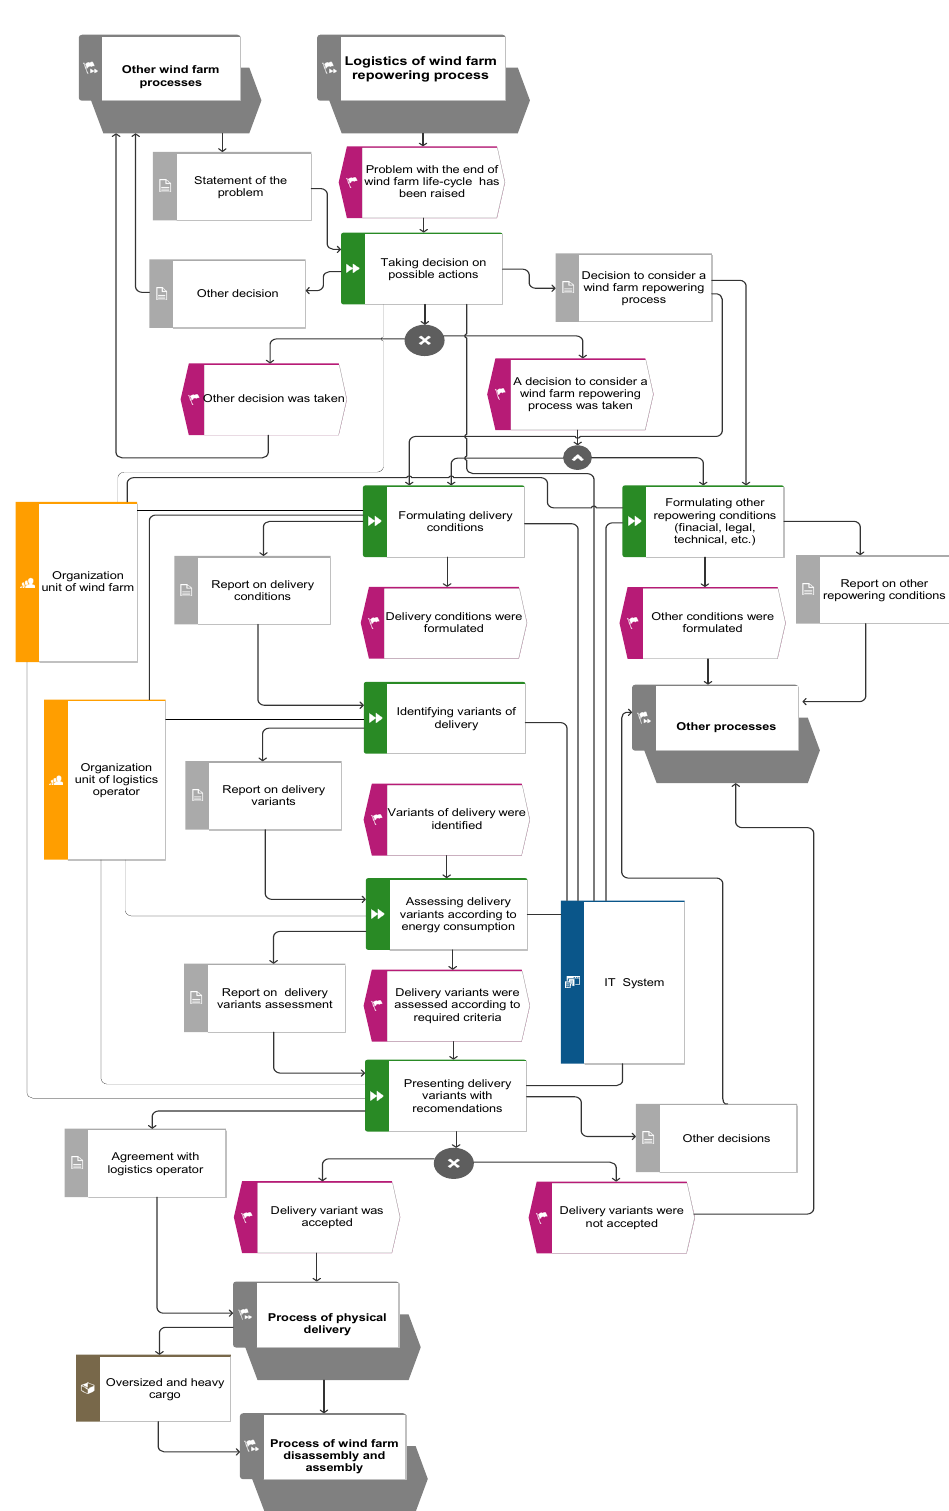
Figure 1. System of the logistics of wind farm repowering. Source: own study based on [3,42], according to EPC notation supported by ARIS Architect&Designer, ver.10.